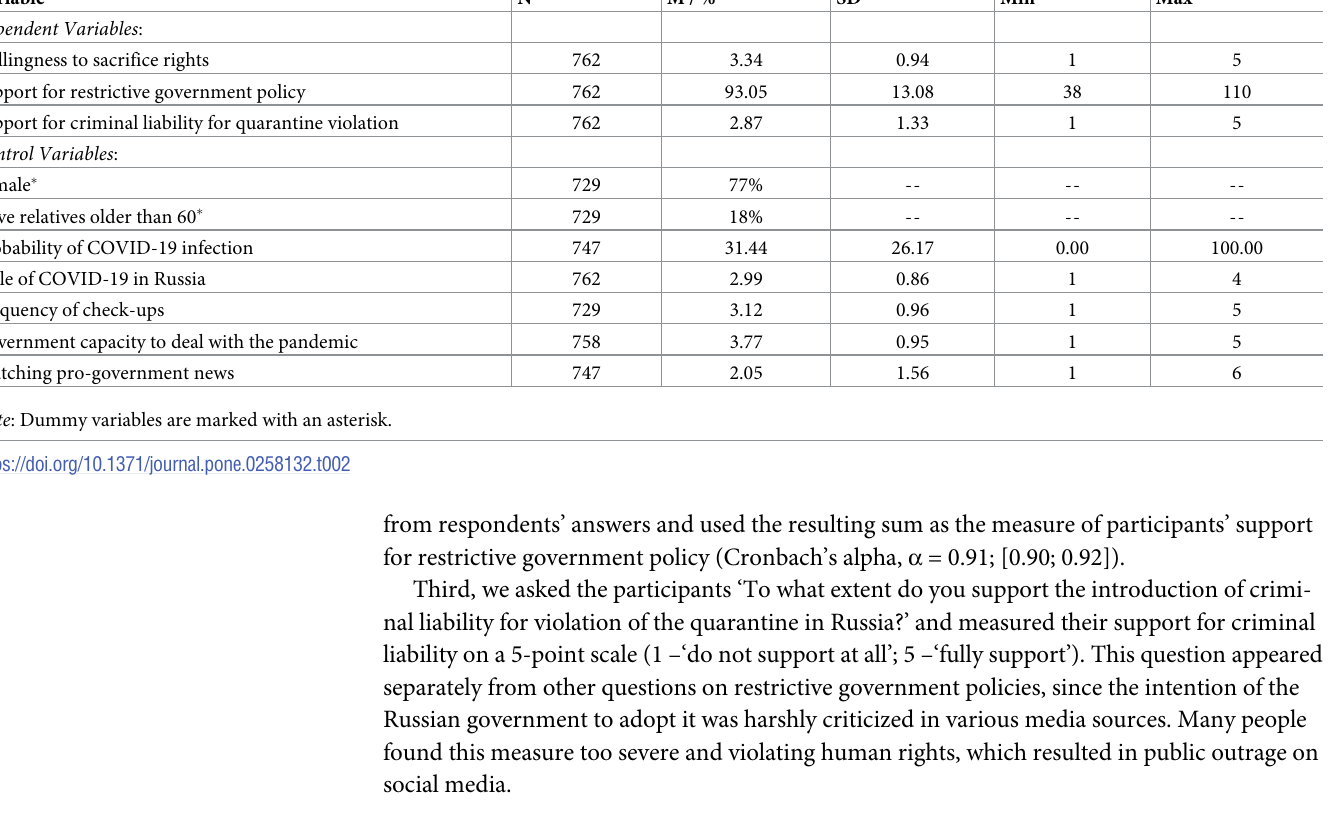
Table 2. Descriptive statistics of dependent variables and pre-treatment covariates.